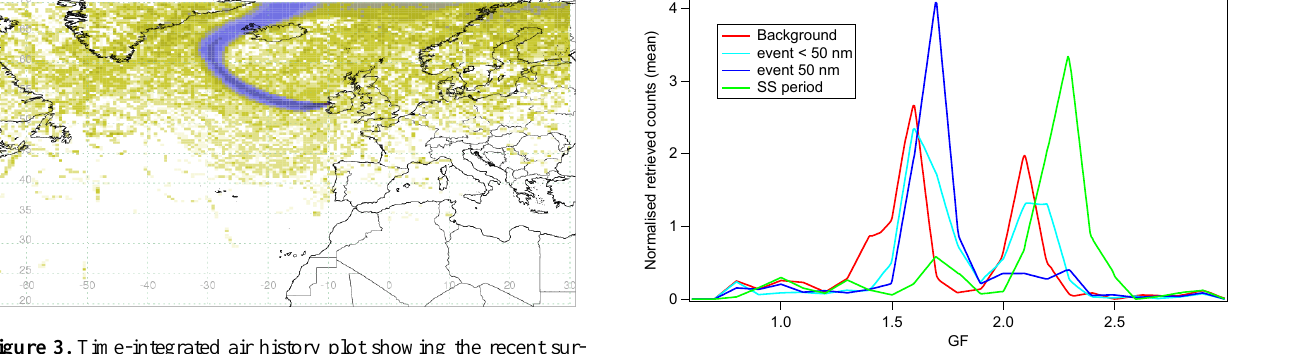
Fig. 4. Averaged HTDMA growth factor (GF) distributions for 51 nm dry diameter particles for the four Figure 4. Averaged HTDMA GF distributions for 51nm dry diam- characteristic periods during the observations. There were usually two main modes, a seasalt mode with eter particles for the four characteristic periods during the observa- GF > 2 , and a GF 1.5-1.7 mode that probably includes sulfate, sea salt and organics. tions. There were usually two main modes, a sea-salt mode with GF > 2, and a GF 1.5–1.7 mode that probably includes sulfate, sea salt and 30